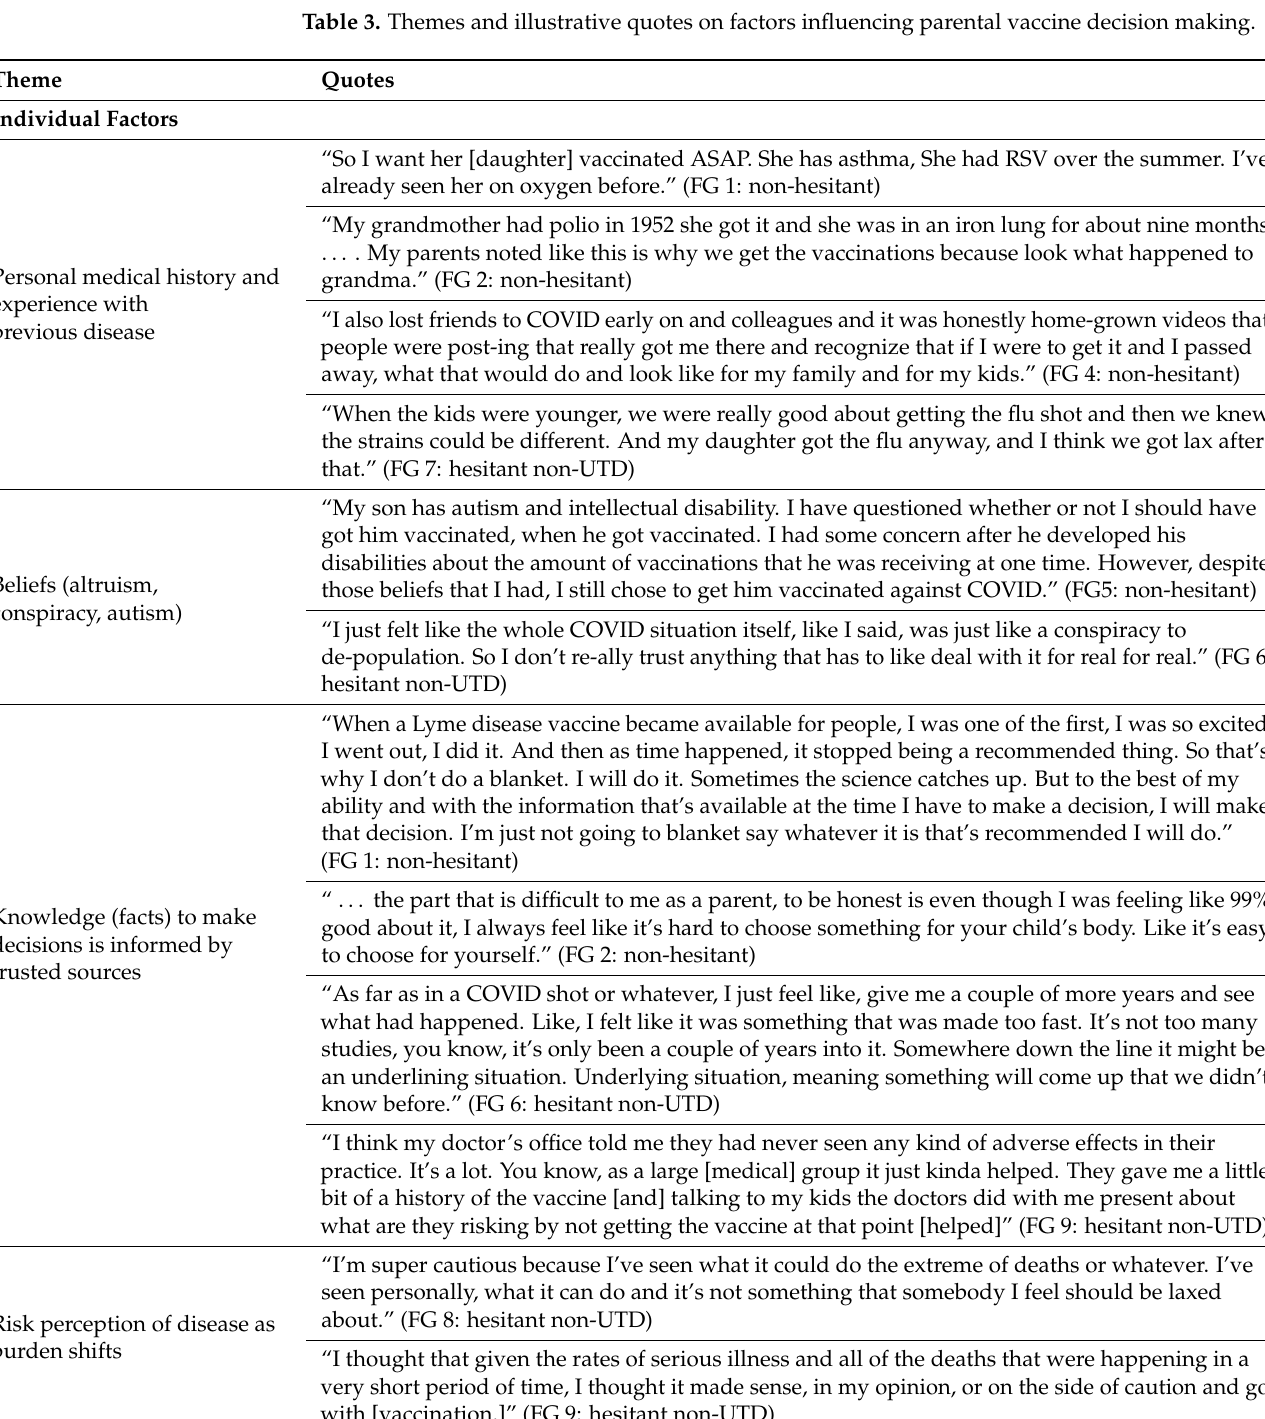
Table 3. Themes and illustrative quotes on factors influencing parental vaccine decision